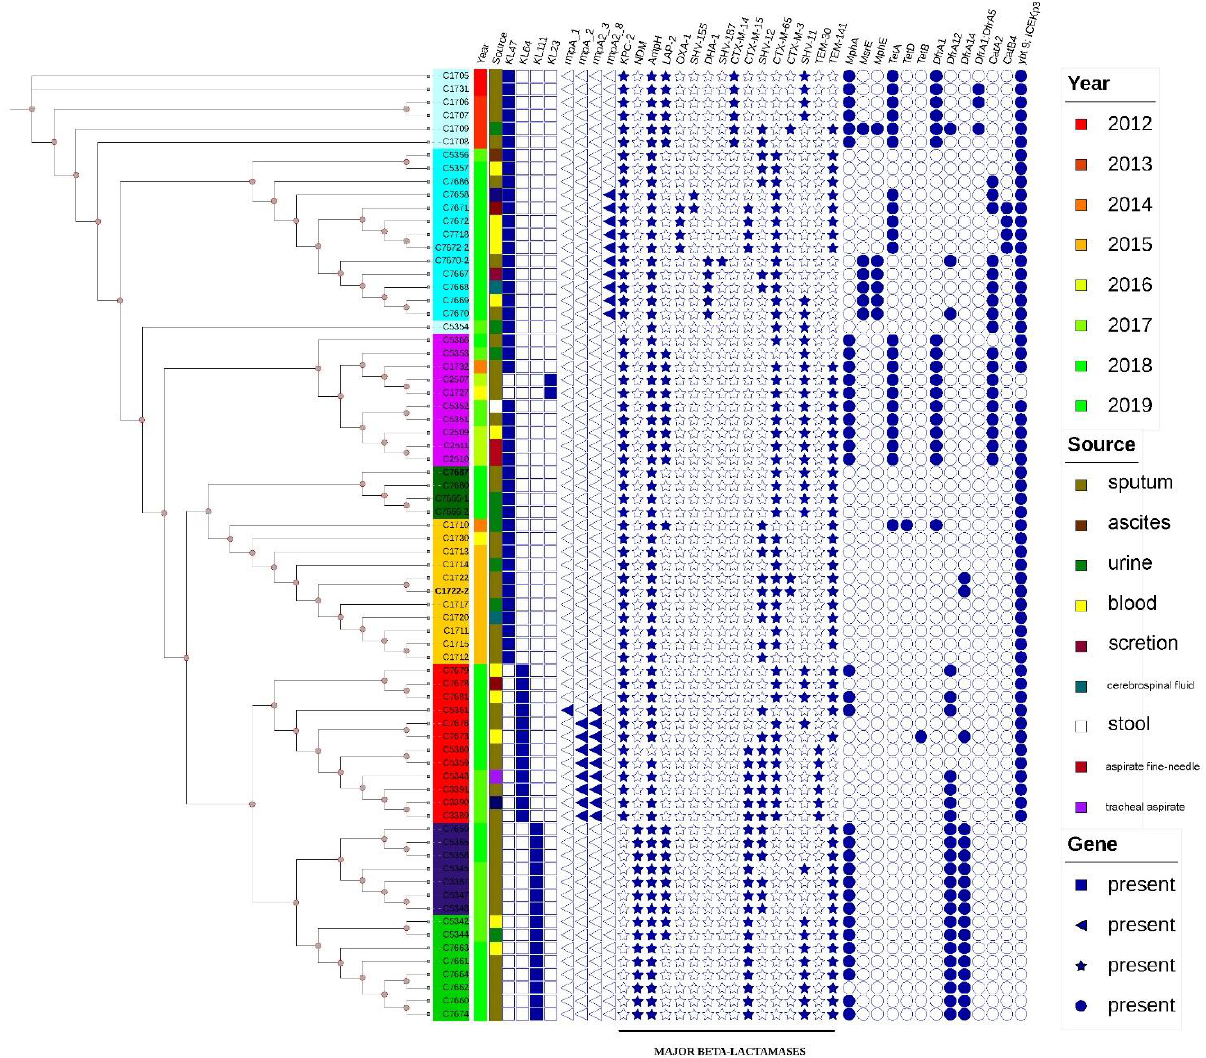
Figure 3. Phylogenetic tree of the core genome for all sequence type 11 Klebsiella pneumoniae strains.